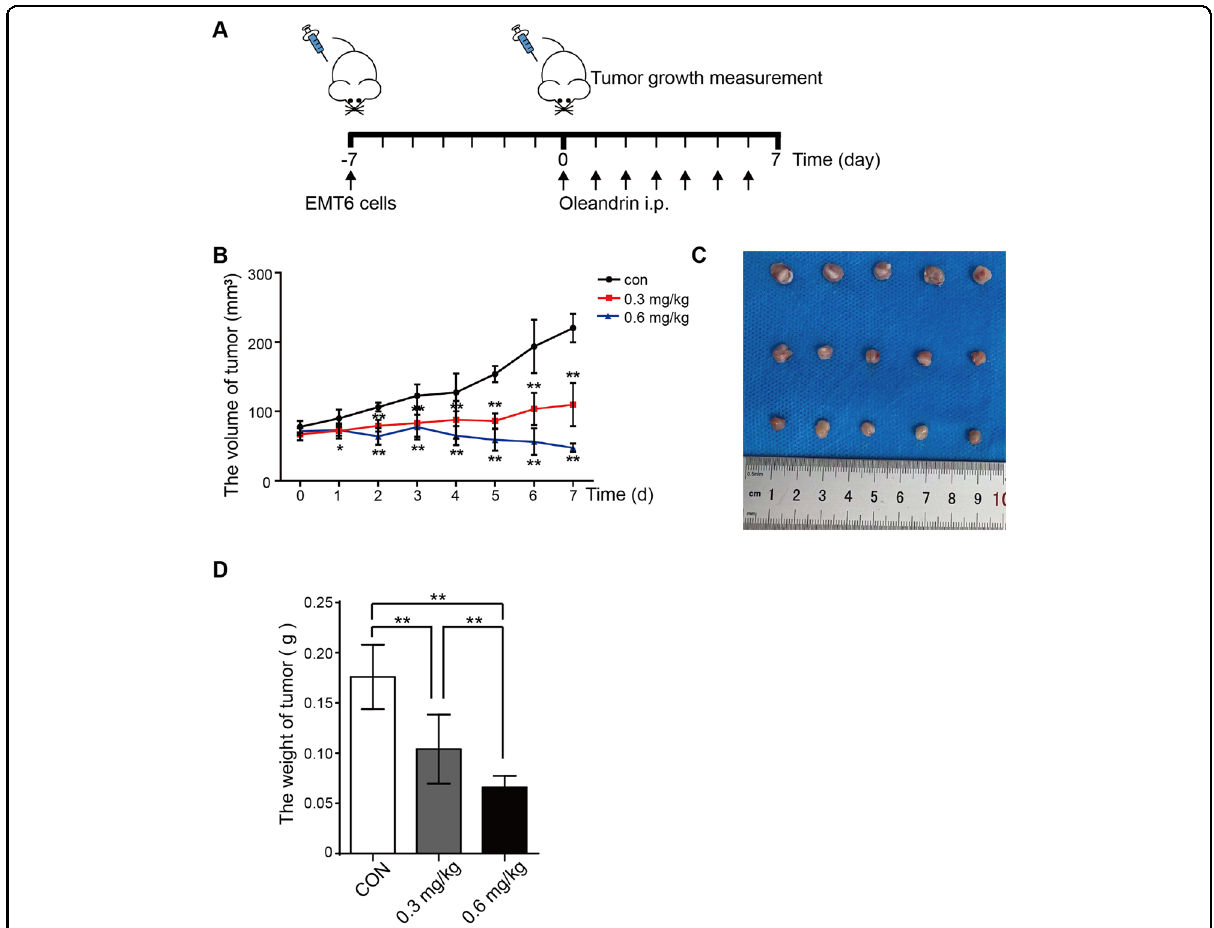
Fig. 4 Oleandrin suppresses tumor growth in mice. A Diagram of procedure for mouse tumor model. First, 2 × 10 5 EMT6 cells were transplanted into mammary fat pads of BALB/c mice. Seven days after transplantation, tumor-bearing mice were divided into 3 groups and treated with oleandrin at 0.3 and 0.6 mg/kg intraperitoneal for 7 days. Mice treated with PBS were used as control. B Tumor volume was measured every day and quanti fi ed as 0.5 × length × width × width. The volume was expressed as mean ± SD ( n = 5) and represented as tumor volume – time curves to show (* p < 0.05, ** p < 0.01 vs. control.). C After 7 days of administration, mice were sacri fi ced, and tumors were weighted. The representative tumors were shown. D Tumor weight in each group was expressed as mean ± SD ( n = 5, ** p < 0.01 vs.